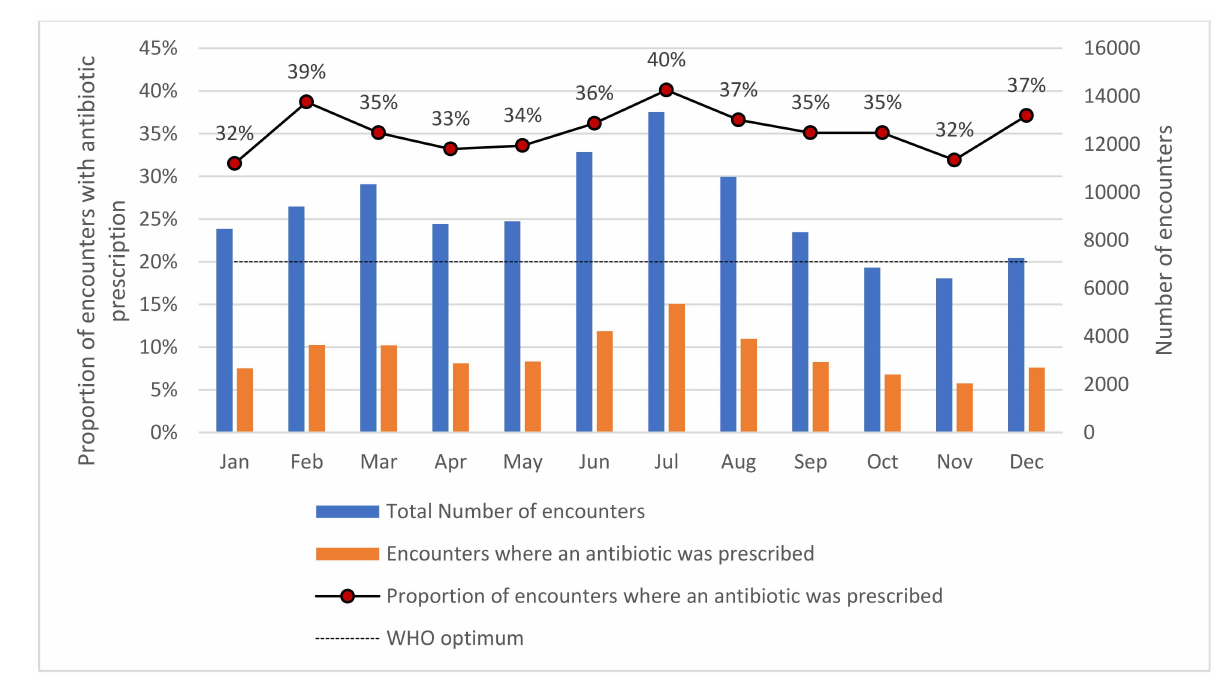
Figure 1. Monthly trend of antibiotic prescriptions in the outpatient department of University Hospital, KNUST, in Ghana between January and December 2021, KNUST—Kwame Nkrumah University of Science and Technology.